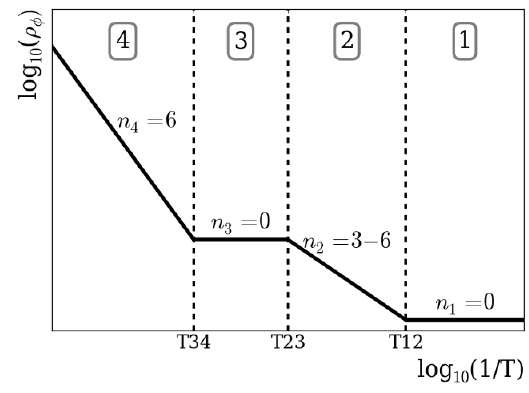
Figure 1. Evolution with temperature of the scalar (cid:12)eld density in representative power-law models of